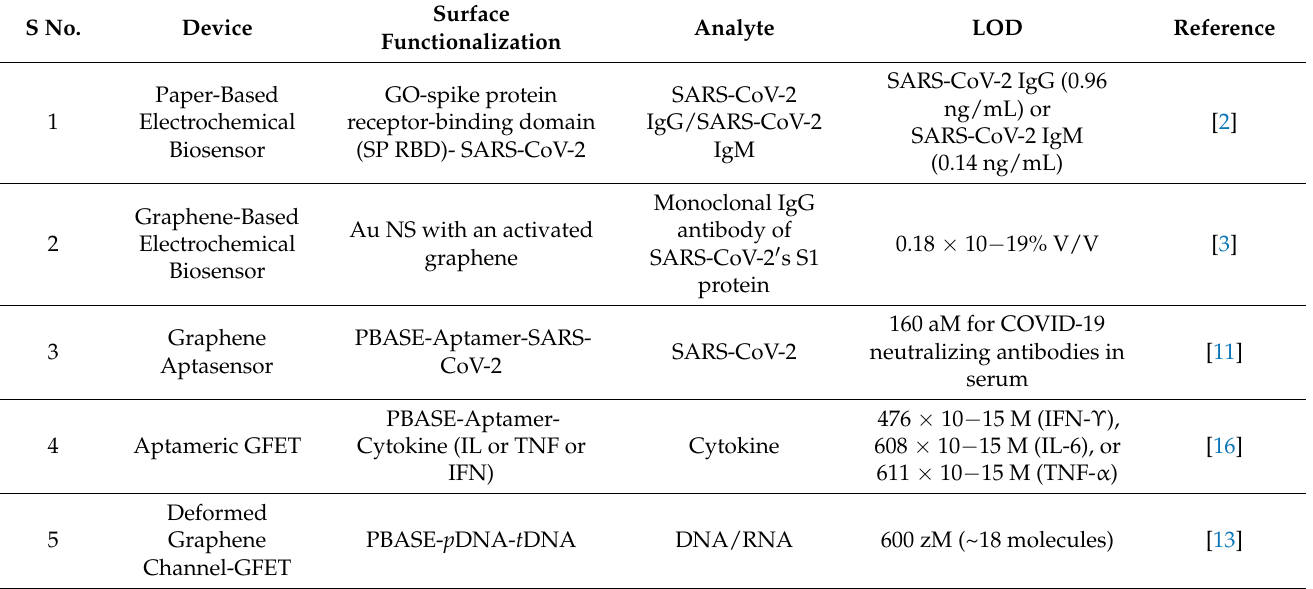
Table 1. An overview on recently reported methods for the determination of macromolecules using various